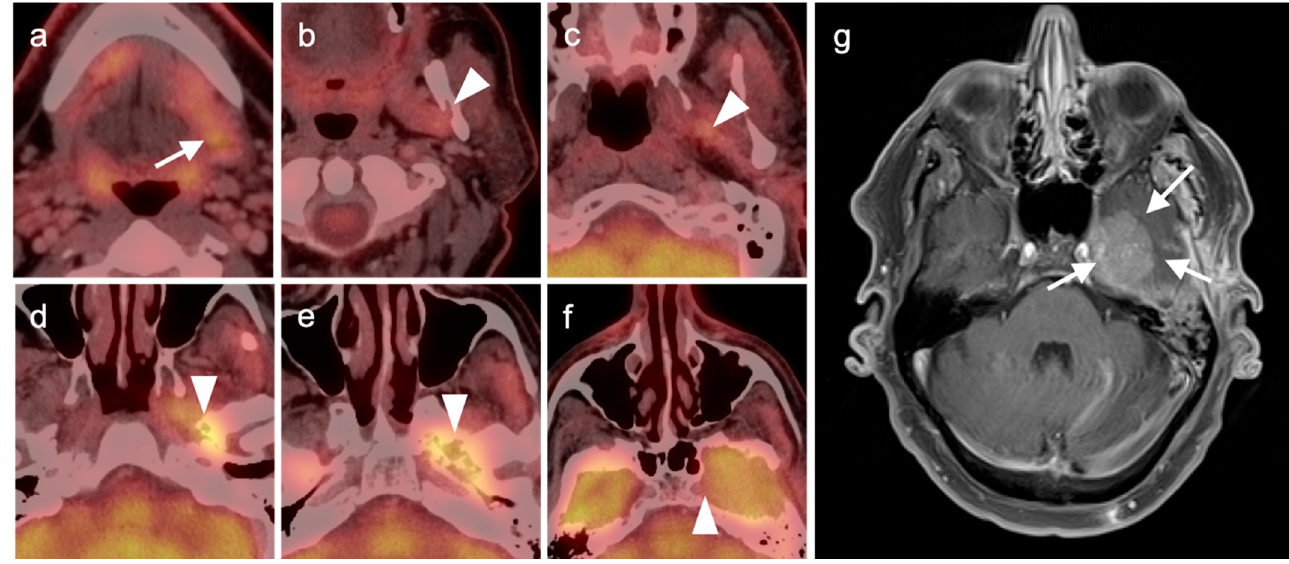
Figure 9. FDG PET-CT findings of perineural spread of tumor. ( a ) Small mildly hypermetabolic adenoid cystic carcinoma of the left sublingual gland (white arrow); ( b – e ) spread along the mylohyoid nerve, inferior alveolar nerve, and mandibular nerve (white arrowheads); ( f ) spread of tumor into the trigeminal cistern (Meckel’s cave) and into the middle cranial fossa, which is difficult to appreciate on FDG PET-CT (white arrowheads); ( g ) tumor is better defined by contrast-enhanced axial T1 with fat saturation MRI extending from the trigeminal cistern into the middle cranial fossa ( g , white arrows).